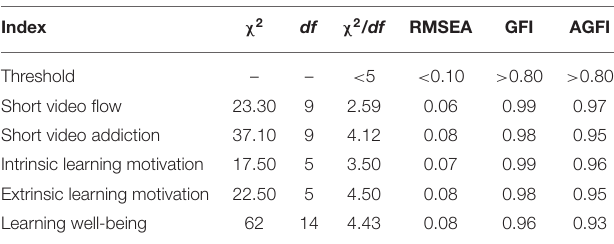
TABLE 3 | First-order CFA